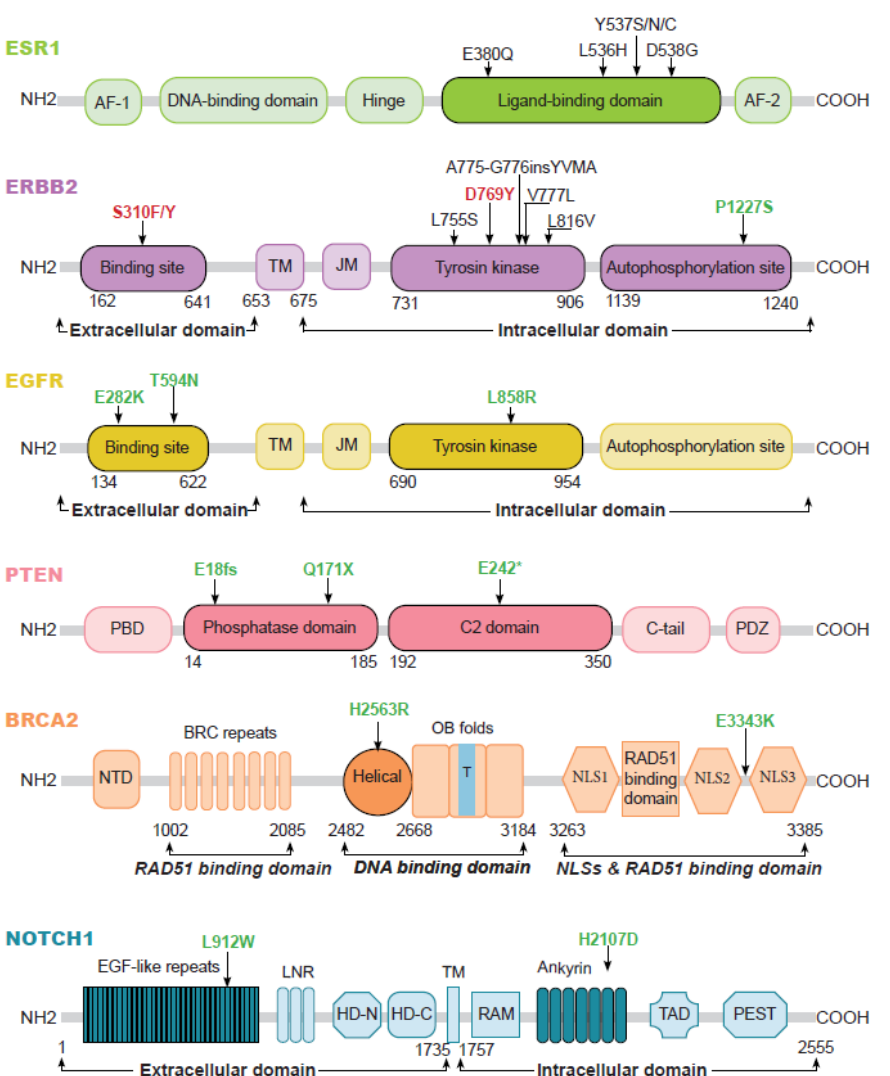
Table 2. Univariate and multivariate meta-regression.